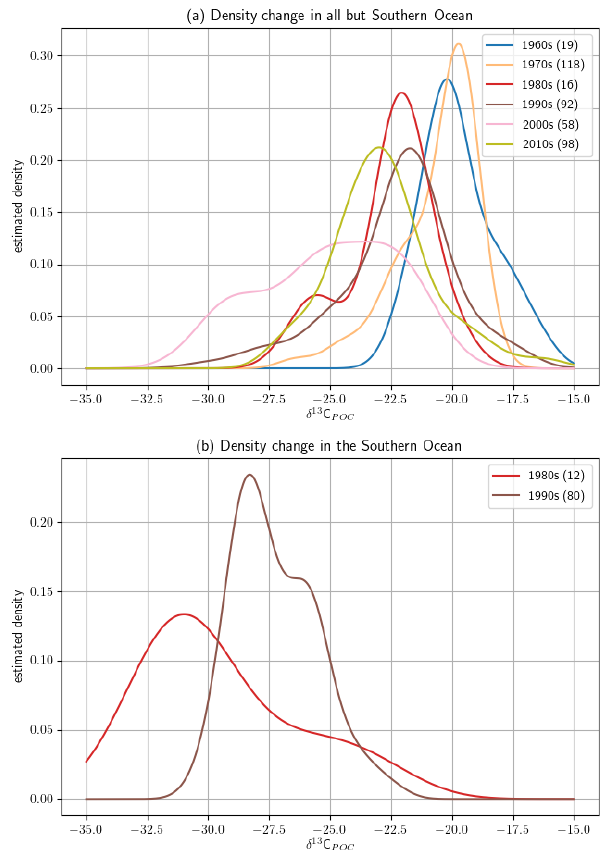
Figure 11. The decadal shift in δ 13 C POC values for all but the Southern Ocean (a) and only the Southern Ocean (b) shown by esti- mated densities of δ 13 C POC values. The differently colored graphs refer to the individual decades. Southern Ocean data are sparsely covered, and the region does not provide enough data for a reason- able comparison.